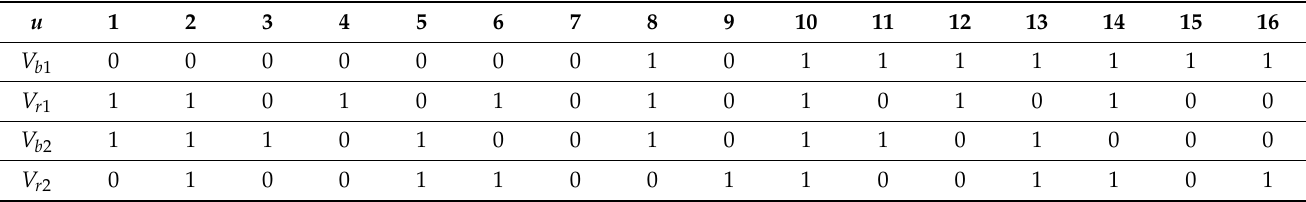
Figure 12. Effective force for different valve configurations using HAWE cylinders. Table 3. Cylinder chamber state for different valve configurations ( u ). V b 1/2 and V r 1/2 are the bore and rod side chambers of cylinder 1/2. Chamber state of 1 and 0 indicate pressurized and depressurized, respectively.